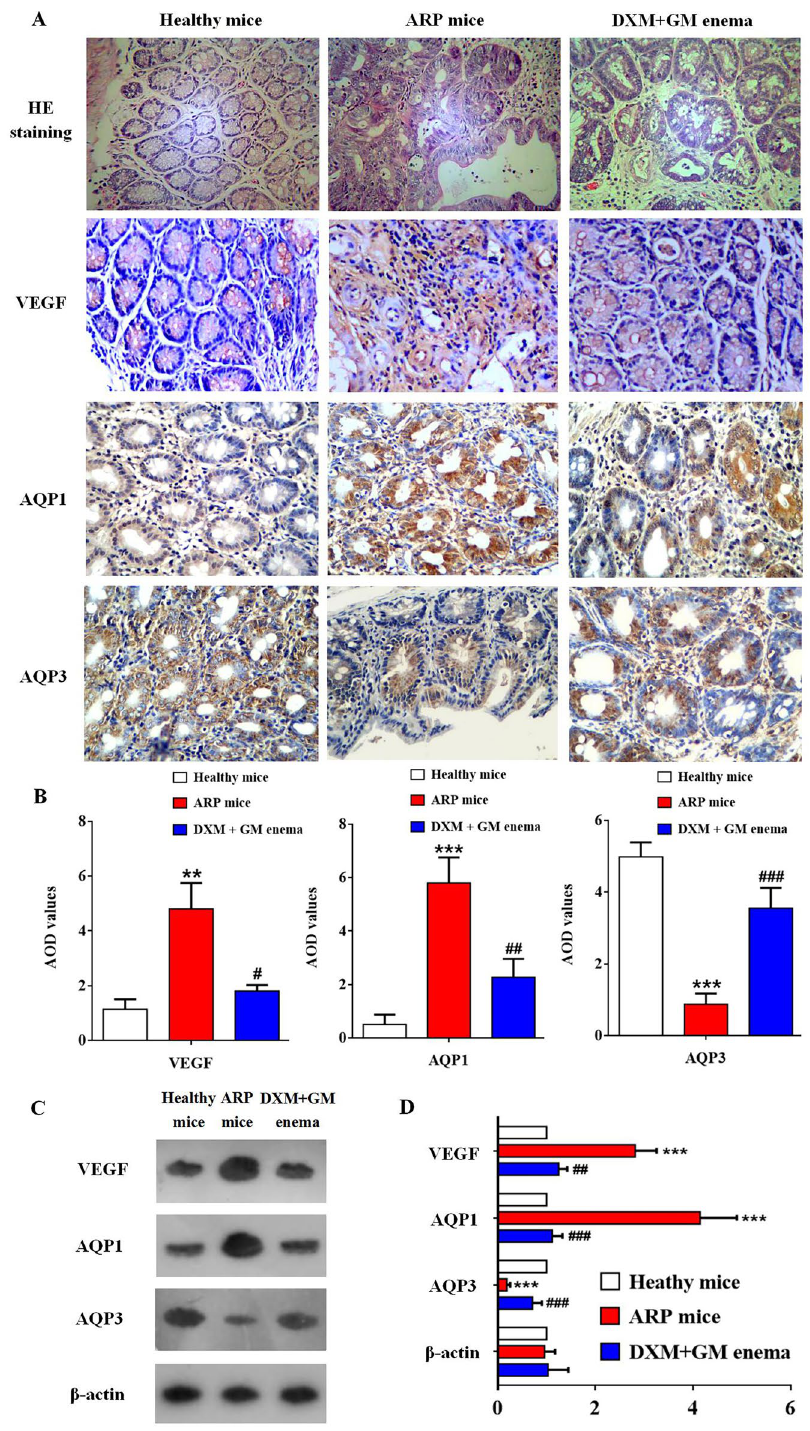
Figure 7. DXM + GM enema inhibits angiogenesis by downregulating VEGF and AQP1 and upregulating AQP3 in ARP mice. ( A ) The immunohistochemistry of VEGF, AQP1, AQP3 and HE staining in different groups of mice (n = 10 for each group) were observed under light microscopy (scale ×400). ( B ) AOD values of NF-κB were detected by immunohistochemistry in different groups of mice (** P < 0.01, *** P < 0.001, # P < 0.05, ## P < 0.01, ### P < 0.001). ( C ) The expression of VEGF, AQP1 and AQP3 in different groups of mice was tested by using western blot. ( D ) The expression of VEGF and AQP1 in rectal tissue of ARP mice was significantly higher than that of healthy mice (*** P < 0.001). However, the expression of AQP3 in rectal tissue of mice in ARP model group was decreased significantly compared to healthy control group (*** P < 0.001). DXM + GM enema down- regulated VEGF and AQP1, while up-regulated AQP3 ( ## P < 0.01, ### P <